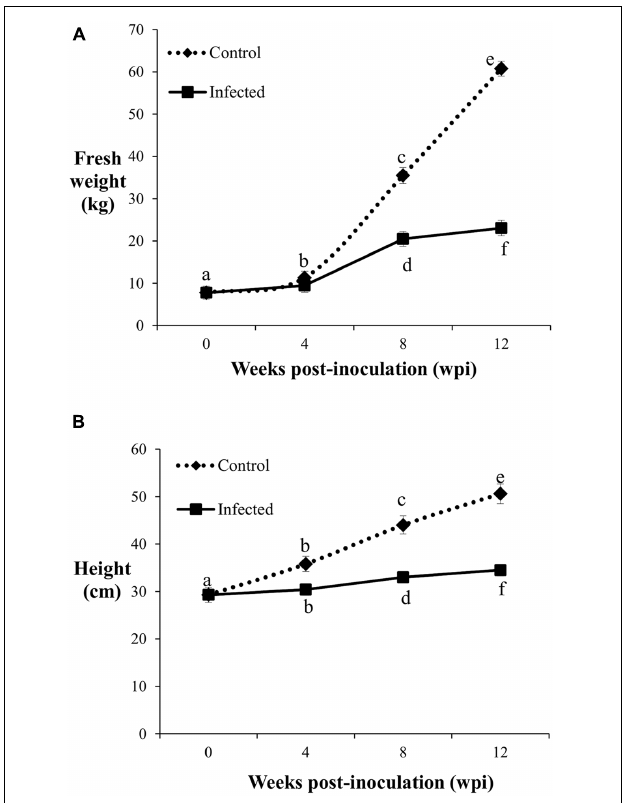
FIGURE 2 | Fresh weight (A) and height (B) of the control and infected oil palm seedlings challenged with G. boninense at 4, 8, and 12 wpi. Bars represent mean ± standard deviation of four biological replicates. Different letters indicate significant difference at p < 0.05.